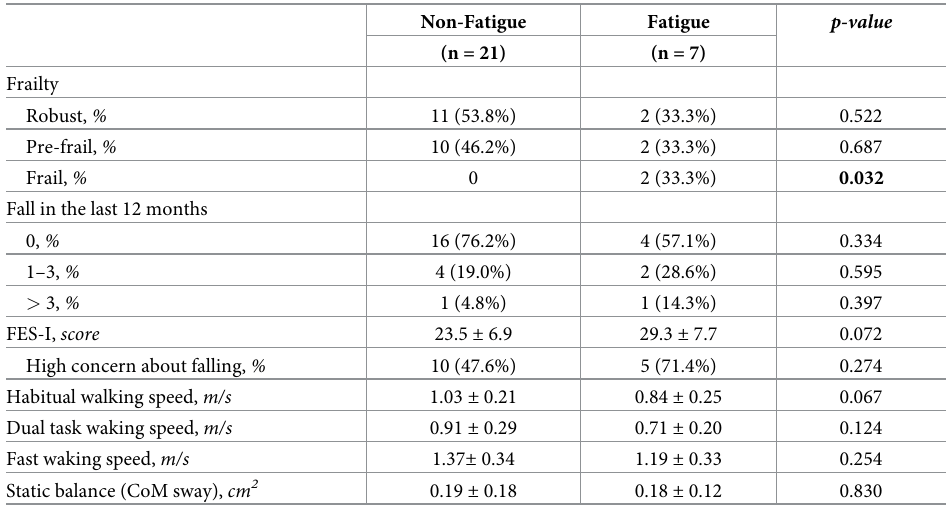
Table 2. Functional characteristics of the study